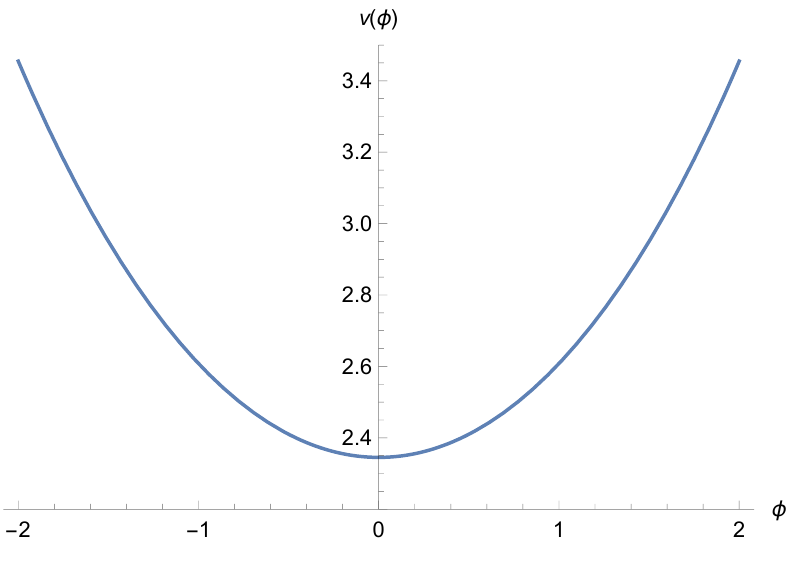
Figure 16. Semiclassical polymer trajectory of the Universe volume v ( φ )